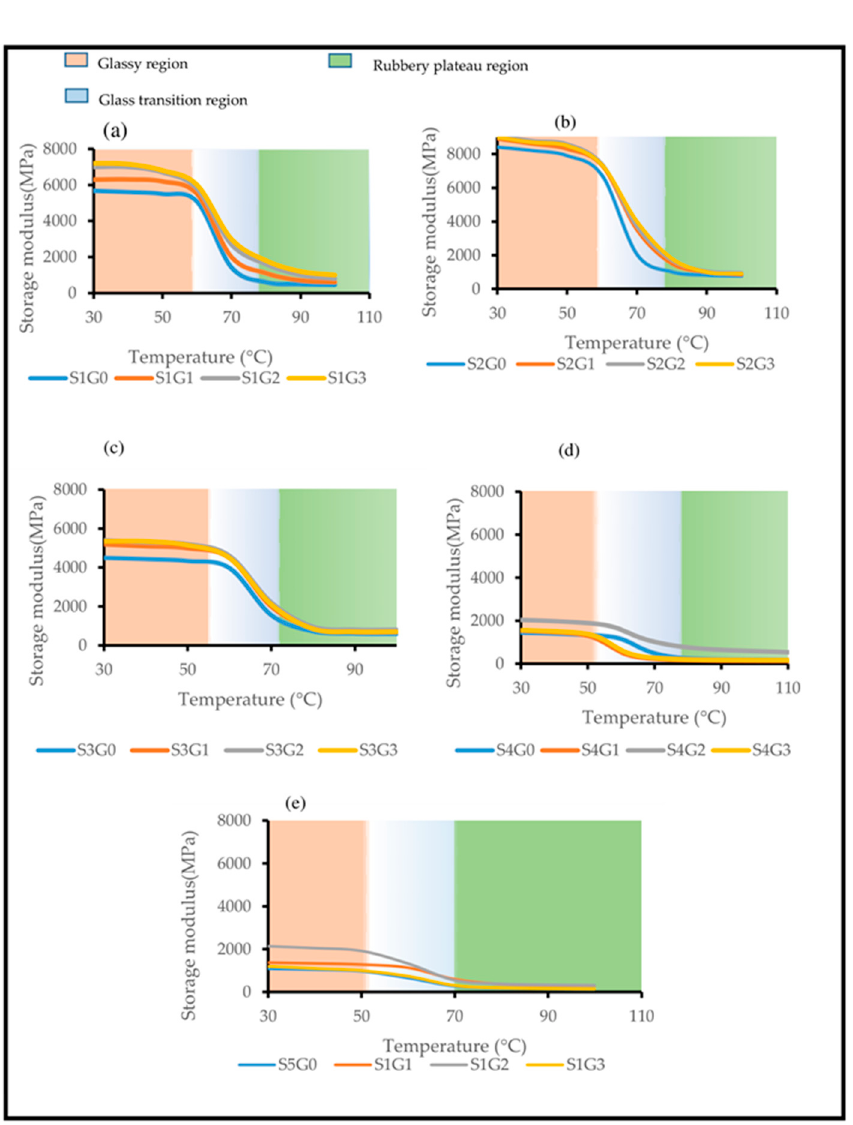
Figure 7. E ff ect of GNP on the storage modulus of laminated composites. ( a ) S1, ( b ) S2, ( c ) S3, ( d ) S4, ( e )